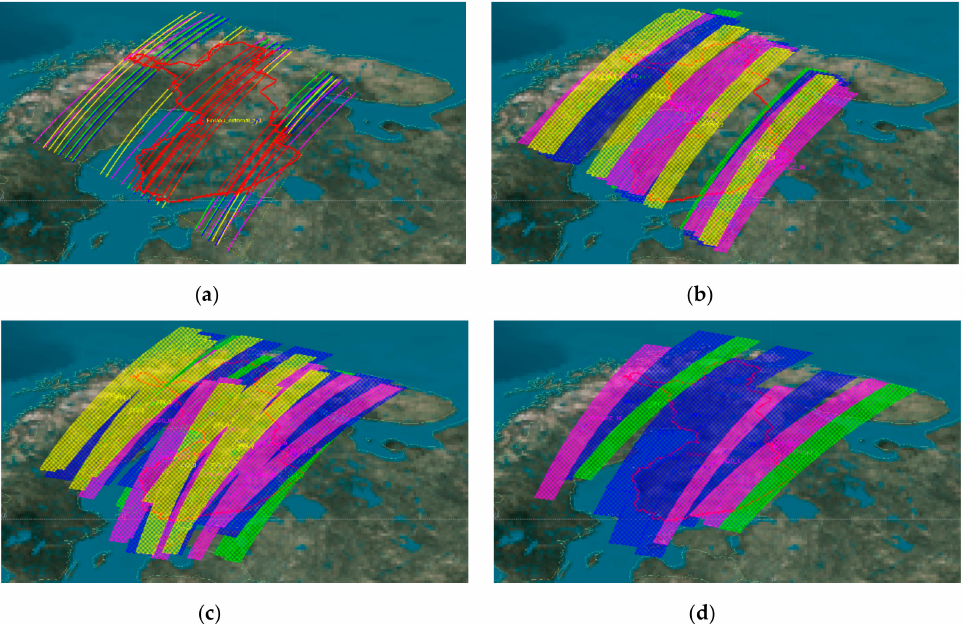
Figure 8. Mission planning results obtained using di ff erent modeling methods in Finland. ( a – d ) Same as Figure